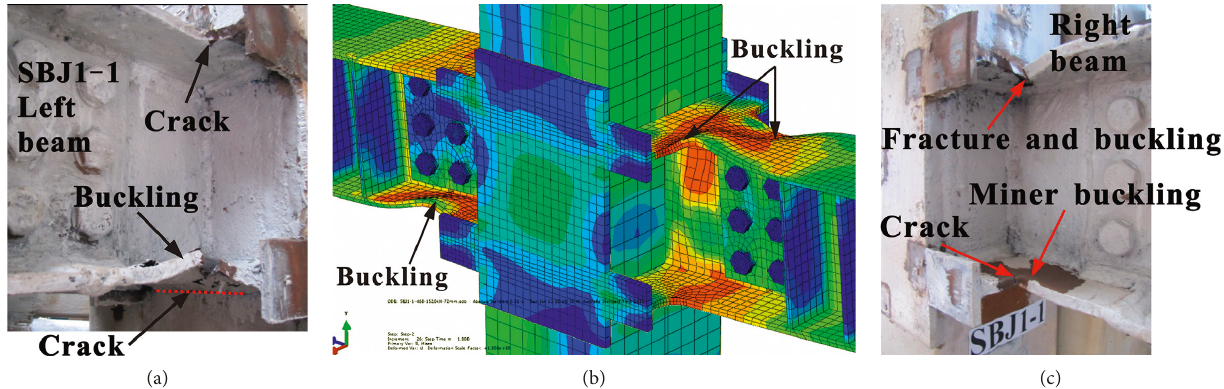
Figure 10: Comparison of the failure modes of the SBJ1-1 specimen determined by test and FEA. (a) Test: left beam segment. (b) FEA. (c) Test: right beam